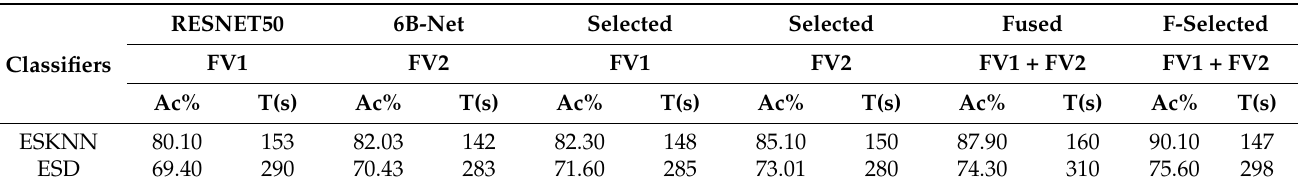
Table 1. Results using proposed feature fusion and selection-based method on BreaKHis dataset with eight classes and ten-fold validation, where Ac% represents the accuracy in percent, and T(S) represents the training time in seconds.